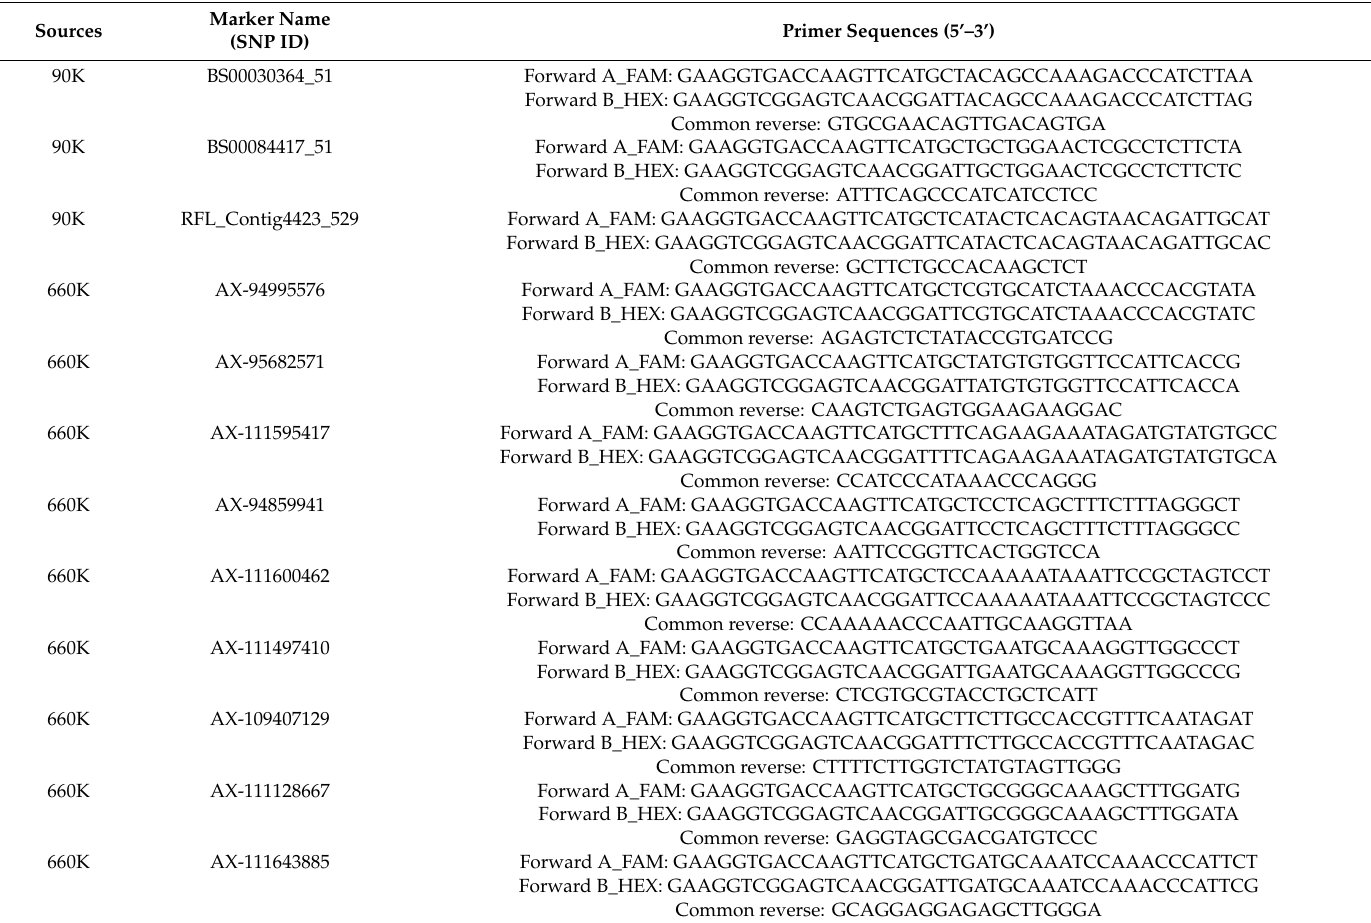
Table 1. Primer sequences of Kompetitive allele-specific polymerase (KASP) markers developed from the 90K and 660K